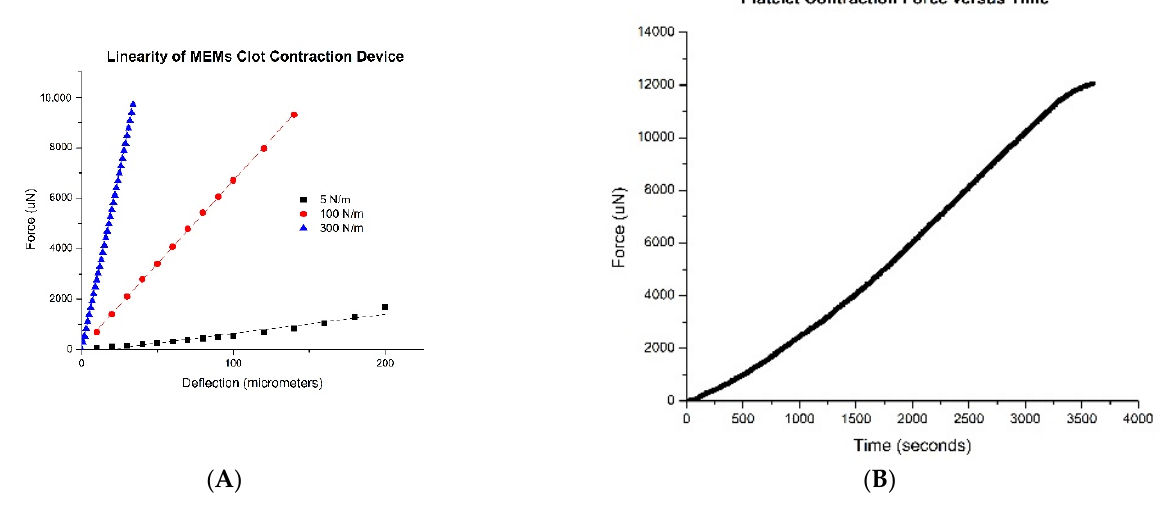
Figure 2. Verification of CCS deflection and force readings ( A ): A nanoindenter was used to deflect the sensor platform between 0 and 100 micrometers (the maximum deflection limit of the CCS) over a range of chip spring constants. A force probe attached to the nanoindenter recorded force production. Each CCS has its own predicted linear increase in force as deflection increases defined by Hooke’s Law, represented by the solid line. The discrete points near each line are actual force readings by the probe at a deflection recorded by the nanoindenter. Chips with a low spring constant will offer lower resistive force over a standard deflection range compared to chips with higher spring constants. Raw Data from CCS ( B ): The software system for the CCS calculates force from the recorded displacement of the tracking prism by the microscope objective. Force in micro Newtons is recorded versus time in seconds and a force curve is generated.